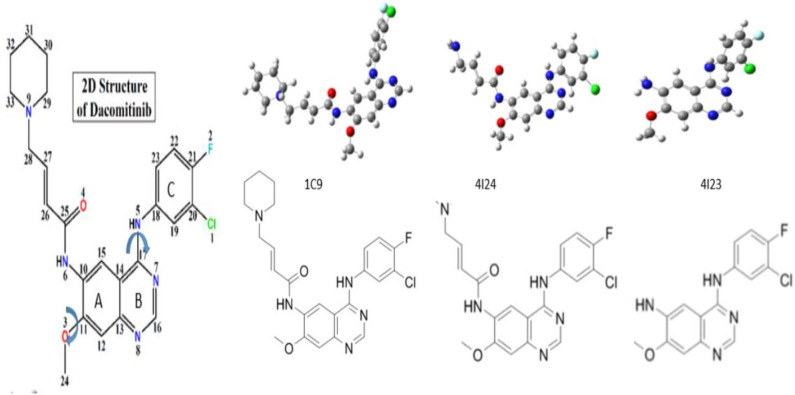
Nomenclature and chemical structure of Dacomitinib ((2E)-N-(4-((3-chloro-4-fluorophenyl)amino)-7-methoxyquinazolin-6-yl)-4-piperidin-1-ylbut-2- enamide). The Arrows indicate the most likely rotations. The crystal structure of (1C9) (Lau et al., 2019) and the co-crystallized structures of Dacomitinib from the Protein Data Bank (PDB), 4I23 and 4I24 (Abdelhameed et al., 2019). The dihedral angles of C(12)-C(11)-O(3)-C(24) and C(19)-C(18)-N(5)-C(17) define the flexibility of the ligand structures, which vary according to the conditions of crystallization of the drug (ligand).